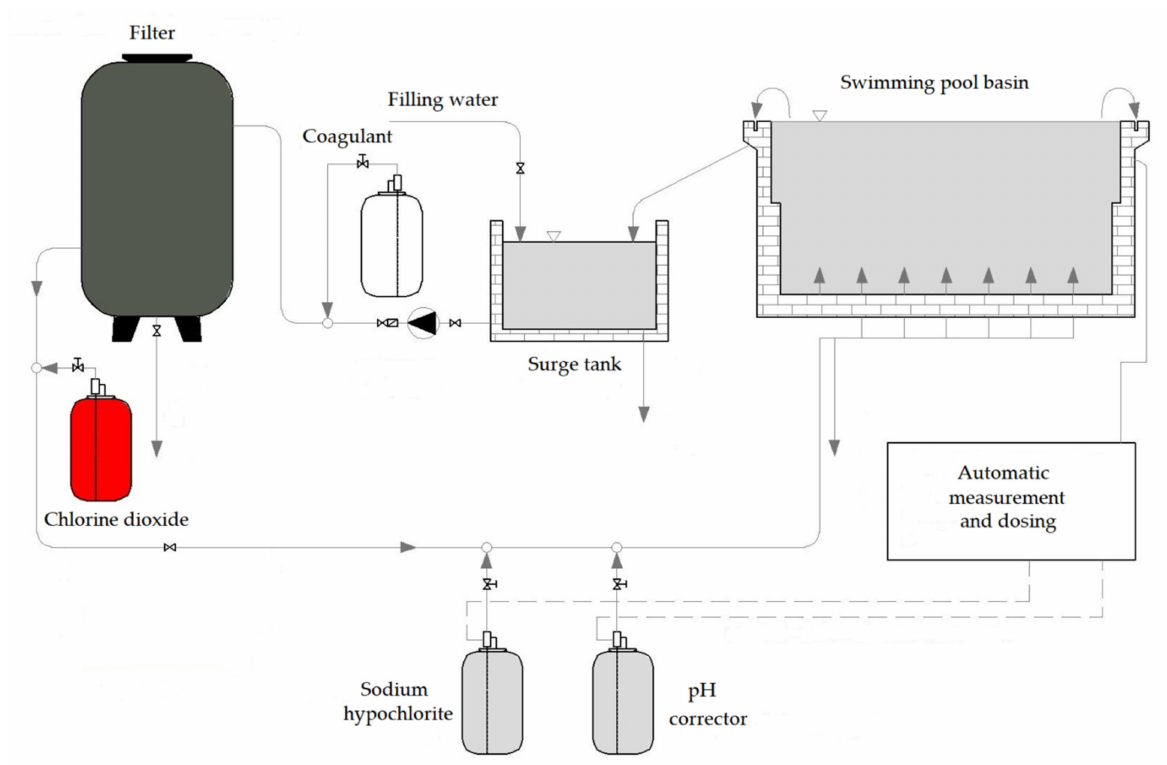
Figure 1. Schematic of swimming pool water treatment in the study facility, showing the localization of chlorine dioxide